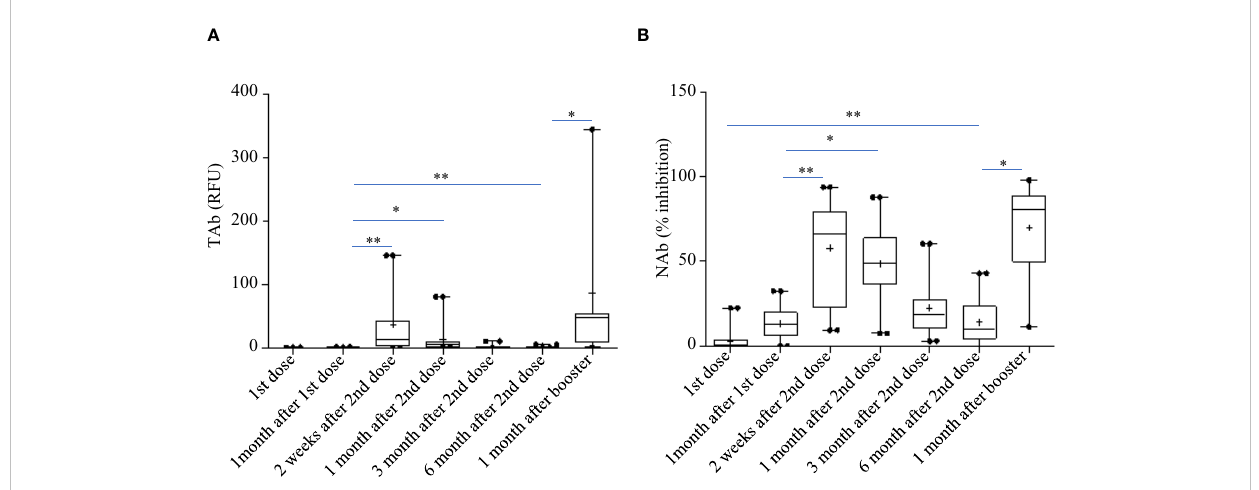
FIGURE 2 Total anti-RBD antibody levels measured by the Pylon TAb assays (A) and the surrogate neutralization abilities measured by the Pylon NAb assays (B) during the study. The horizontal lines indicated the medians and the error bards indicted the IQRs. Only the samples of 45 participants were available at TP7. * p<0.05 **